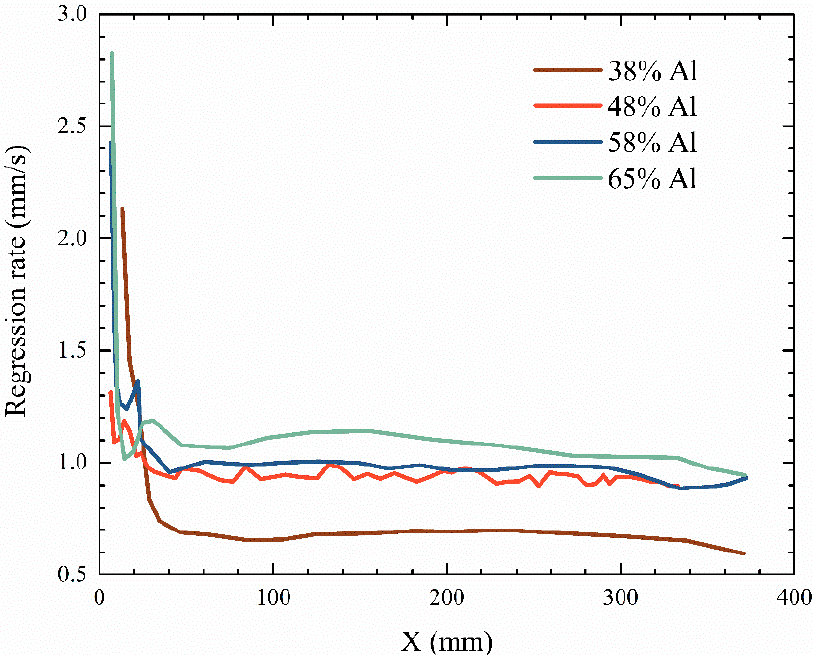
Figure 7. Axial distribution of regression rate.